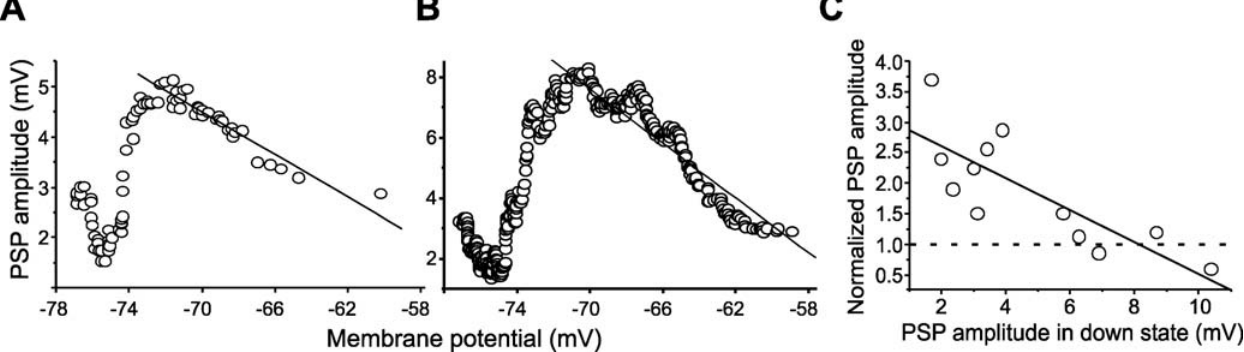
Figure 8. Voltage and amplitude dependence of sensory-evoked synaptic potentials. A. Variation of visually-activated PSPs’ amplitude at different membrane potentials corresponding to up and down states in a cat visual cortex neurons. Each point represents the average of 20 sensory responses. A linear fit to those values between 2 72 and 2 58 mV (R 2 0.95;p , 0.0001) illustrates the voltage dependence of the sensory response. B. Variation of whisker-activated PSPs’ amplitude at different membrane potentials corresponding to up and down states in a barrel cortex neurons. Each point represents the average of 20 sensory responses. Linear fit (R 2 0.92;p , 0.0001) as in A. C. Dependence of the normalized air puff induced PSP amplitude in the up with respect to the down state represented against the absolute amplitude of the sensory-evoked potential during the down states. Note that larger PSPs show less increase during up states (R 2 0.8, t=4.216 on 10 degrees of freedom, 2-tailed significance level is 0.0017). One outlier was removed. doi:10.1371/journal.pone.0000670.g008 PLoS ONE |